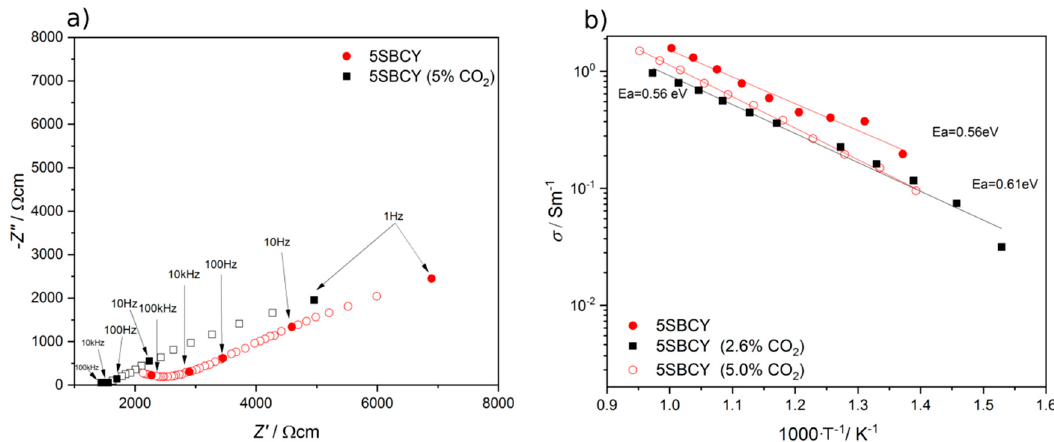
Figure 12. Impedance spectra (Z ʺ –Z ʹ ) recorded for the 5SBCY sample before and after additional heating in a 5 vol.% CO 2 gas atmosphere at 390 °C ( a ); variation in σ vs temperature recorded for 5SBCY before and after additional exposure in 5 or 2.6 vol.% CO 2 ( b ).